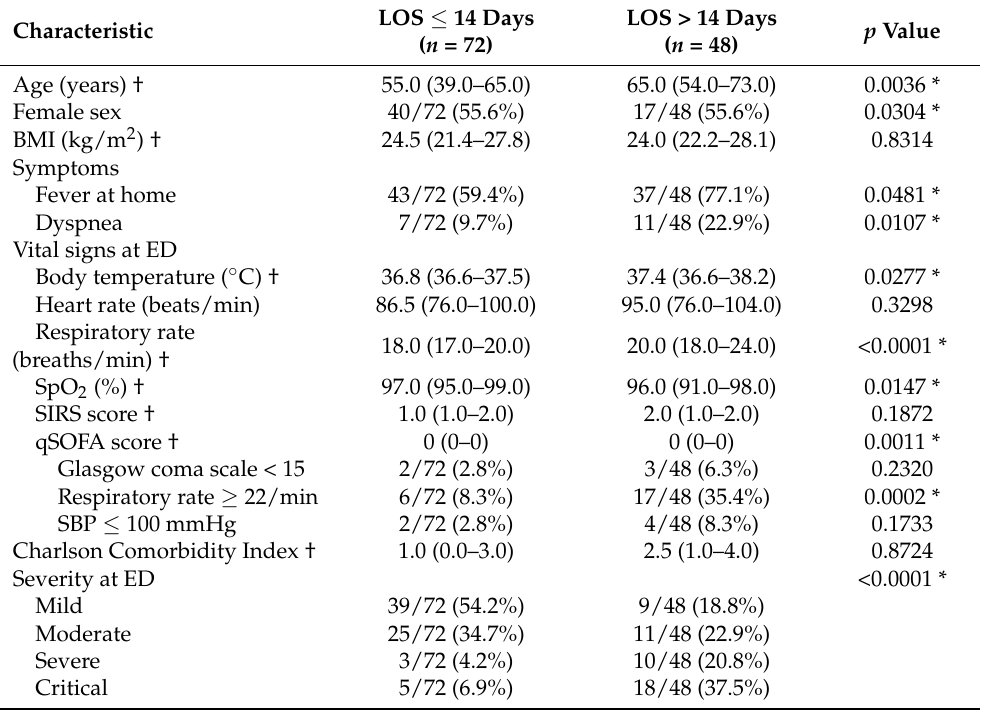
Table 1. Patient characteristics ( n =